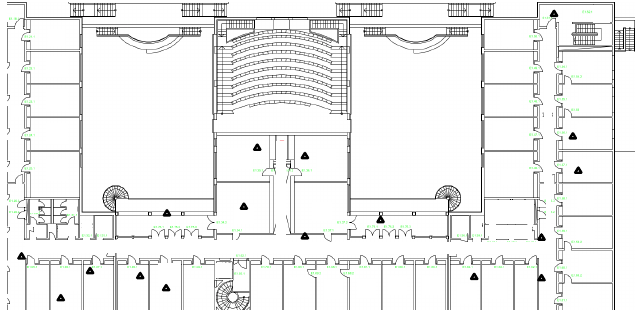
Figure 11. Building layout for indoor localization experiment and the robot trajectory. The triangles mark the positions of sensor nodes, which are placed either in the offices or along the corridor.